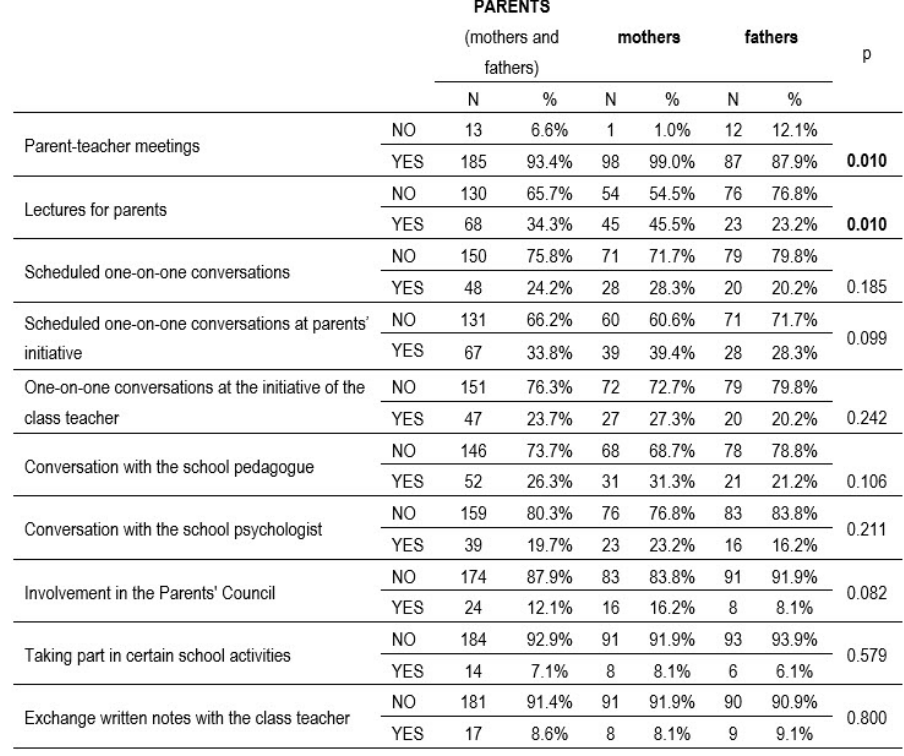
Parents’ participation (fathers and mothers) in various forms of cooperation with